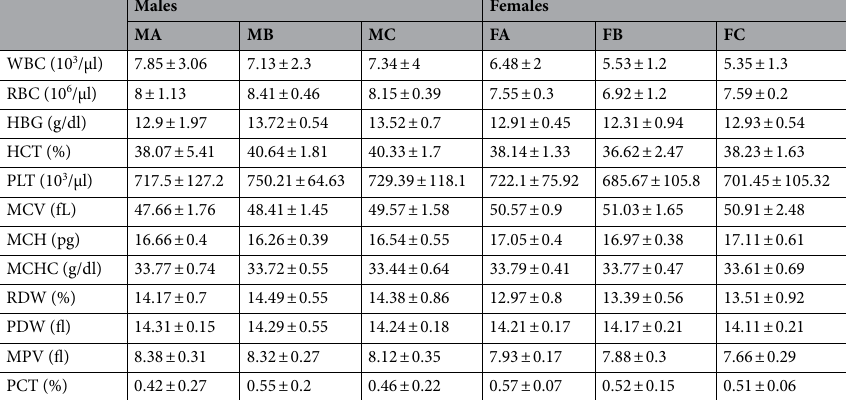
The values of blood biochemistry parameters for all studied groups are shown in Table 2. No apparent differences were observed for all parameters except for ALT. The ALT had significant dif-